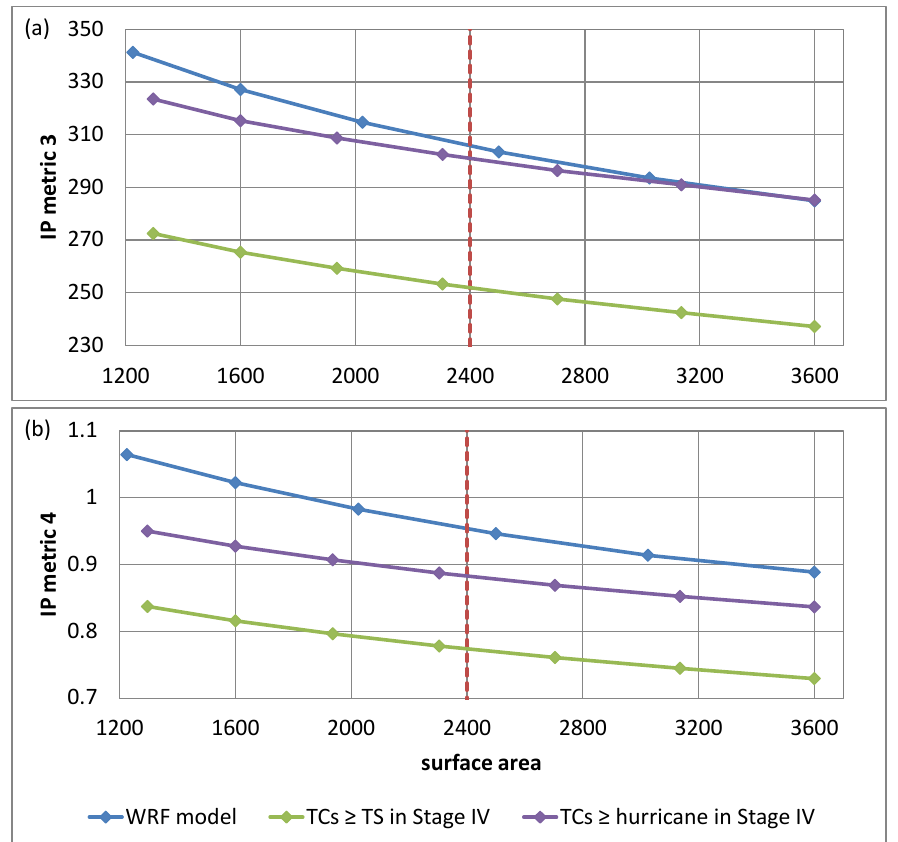
Figure 5. WRF model validation results for the simulation of IP during the period 2005–2017 measured by ( a ) IP Metric 3 (mm) and ( b ) IP Metric 4 for a range of surface areas (km 2 ). These are average metrics calculated by averaging the metrics of all landfalling TCs during the period 2005–2017. The blue curve gives the metrics for the WRF model outputs whereas the other two curves were obtained by computing the metrics using the Stage IV precipitation dataset in the case where all landfalling TCs with strength ≥ TS strength are considered (green curve), and in the case where all landfalling TCs with strength ≥ hurricane strength are considered (purple curve). The dotted red line indicates a surface area of 2400 km 2